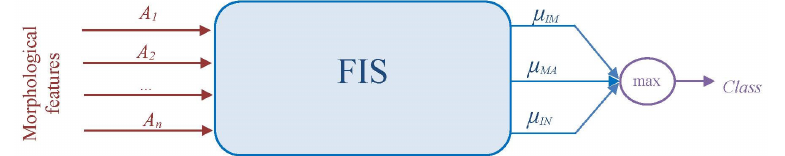
Figure 4. Block diagram of the fuzzy classification system.